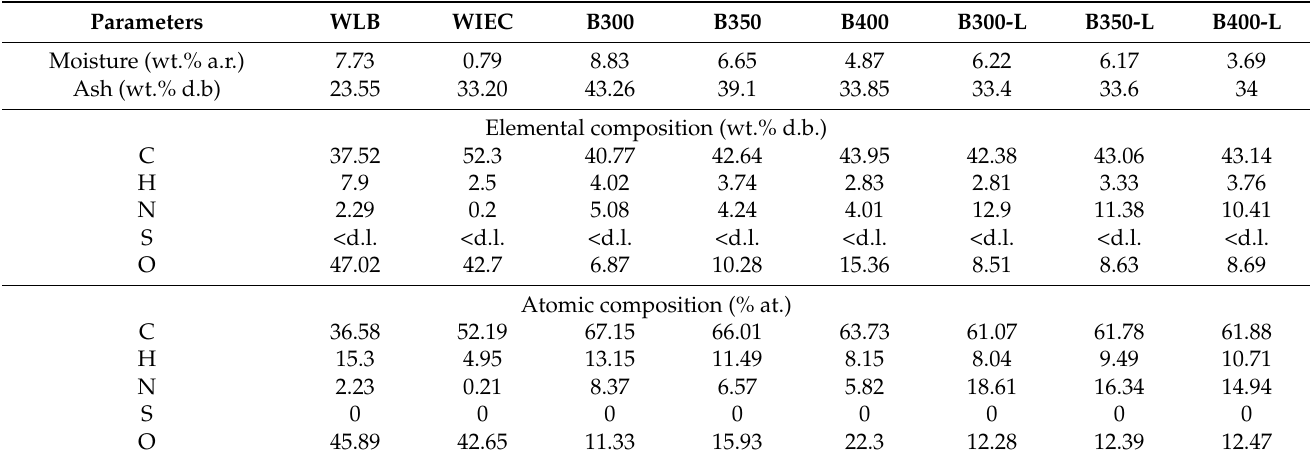
Table 3. Elementary composition of biochars as